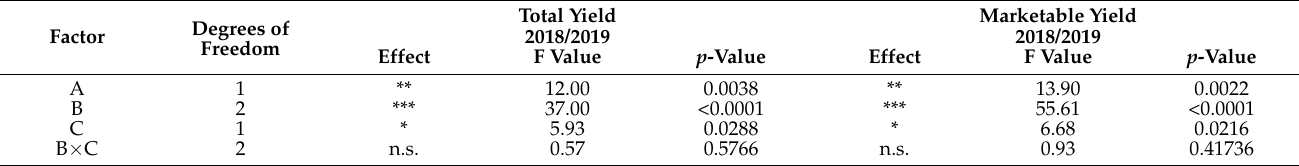
Table 6. Main statistical parameters for total and marketable yield in trials with vegetable soybean grown in two growing seasons, three sowing times, and two growing technologies in Norway, in 2018 and 2019. A: year, B: sowing time, and C: mulching treatment. Total Factor Degrees of Freedom